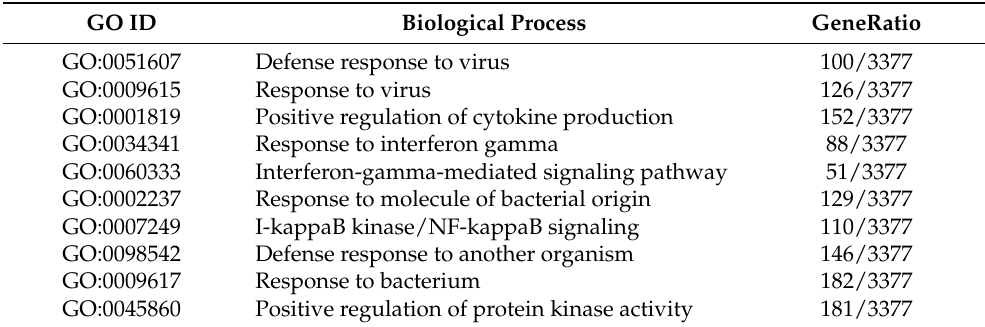
Table 6. Top 10 biological processes significantly (padj ≤ 0.01) enriched in genes differentially expressed in M1_B versus M1_C macrophages.